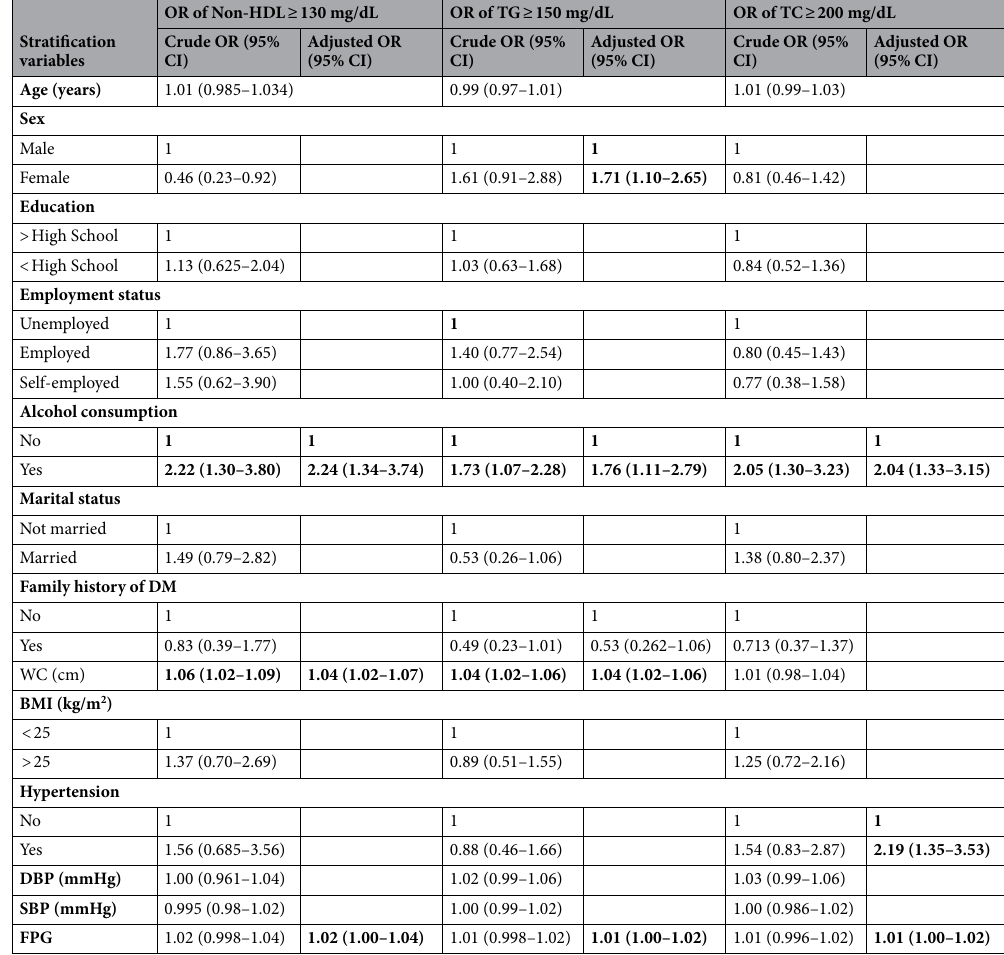
Table 6. Association between LDL, TC, TG, HDL, Non-HDL and TG/GDL ratio with key risk factors: results from logistic models. Significant values are in bold. TG triacylglycerol, TC total cholesterol, HDL-C high- density lipoprotein cholesterol, LDL-C low-density lipoprotein